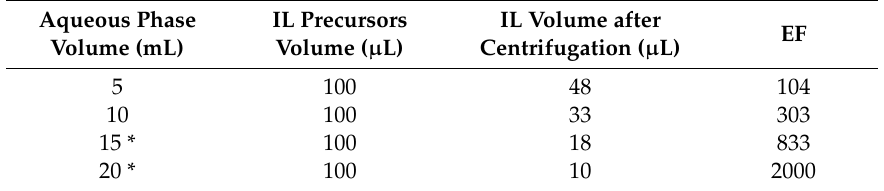
Table 1. IL volume and EF obtained after centrifugation for di ff erent aqueous phase volumes and a fixed IL precursors volume of 100 µ